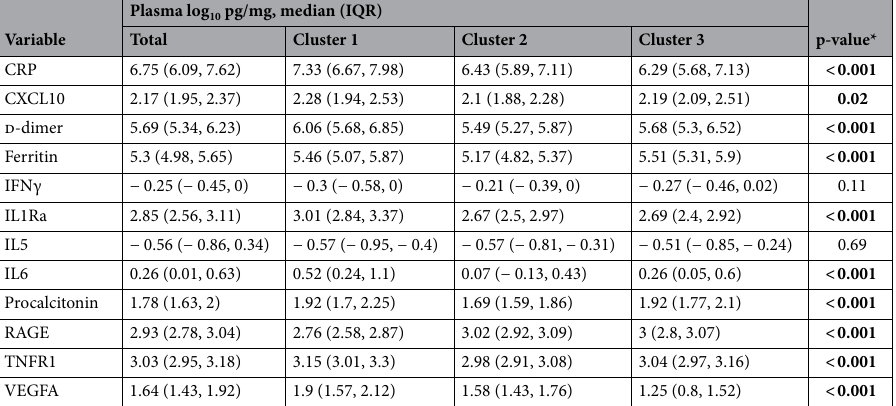
Table 2. Comparison of the Ella biomarkers across TDA clusters. For each subject, one sample was selected based on highest coefficient of variation. *Distributions among all clusters compared using a Kruskal–Wallis test. Significant values are in